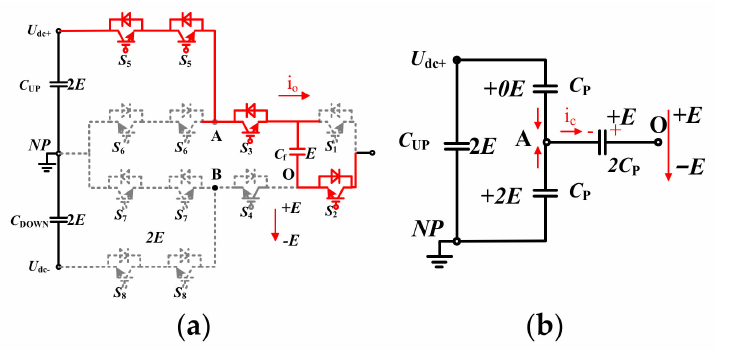
Figure 9. ( a ) Conduction path and potential difference when S3, S4 equals to 1.0 ( b ) Equivalent circuit of the charging process.